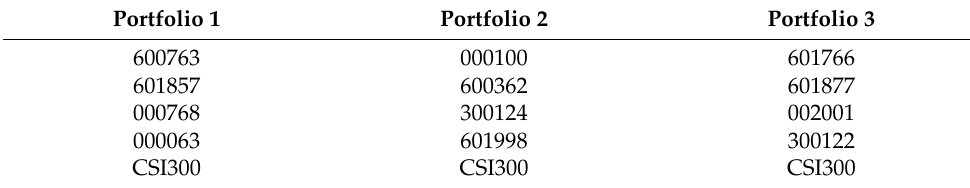
Table 1. The stock code of different experiments.